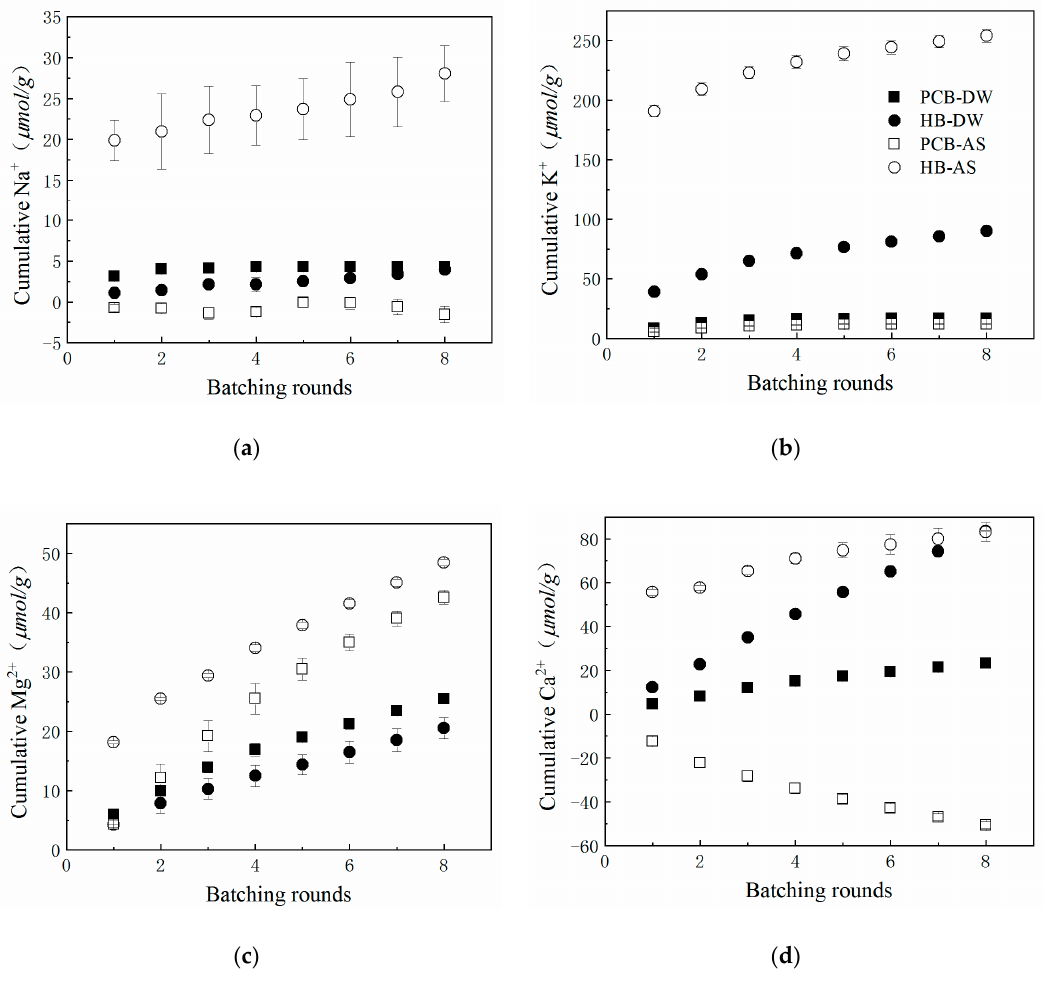
Figure 5. Cumulative low valence metal cations leached from PCB and HB in DW or AS. ( a ) Na + ; ( b ) K + ; ( c ) Mg 2+ ; ( d ) Ca 2+